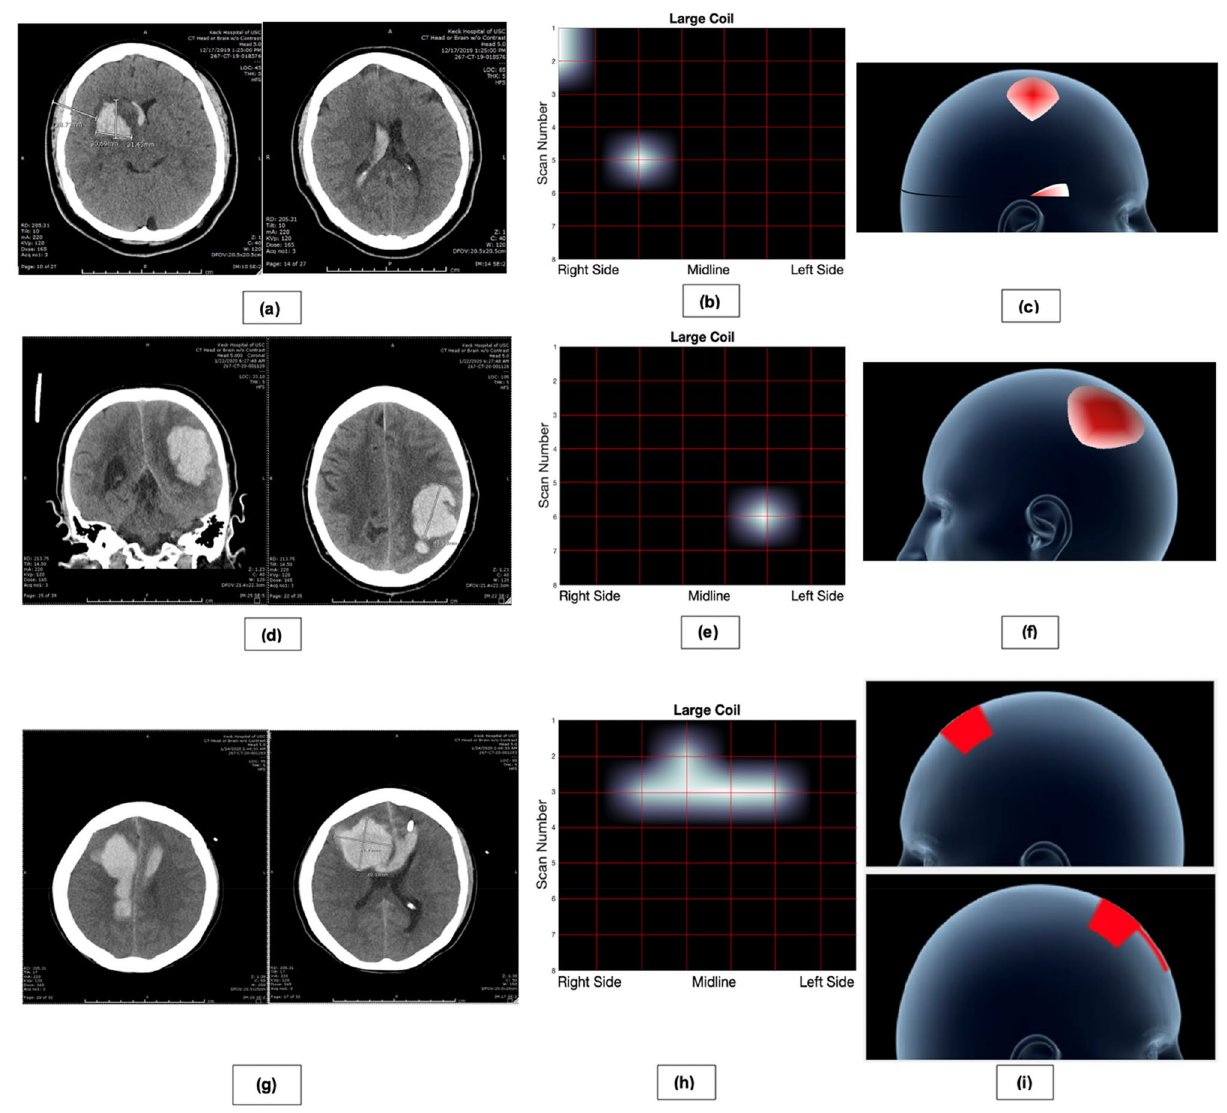
Figure 4. CT imaging, 2D ECD sensor imaging, and 3D ECD sensor imaging for three hemorrhagic stroke patients. The 2D images were produced by continuously scanning across the 8 scanning rows and then averaging each row into 8 equidistant points, with interpolation, to create an 8 × 8 heatmap. As such, lesions are shown on the vertices of the heatmap if detected. To create the 3D images, the 2D heatmaps were projected onto a hemispherical head template. ( a ) CT imaging showing a right basal ganglia ICH and associated IVH in Patient #1. ( b ) Two-dimensional data gathered from ECD sensor. Of note, the Large Coil has the largest magnetic field depth, and thus was able to detect both hemorrhages. ( c ) Three-dimensional projections of each coil. 3D graphics can be created in real-time to rapidly guide clinical judgement and reduce time-to-treatment. ( d ) CT imaging showing a left parietal lobar ICH in Patient #2. ( e ) Two-dimensional data gathered from ECD sensor scanning. ( f ) Three-dimensional projections of the lesion. ( g ) CT imaging showing bilateral ICH, right greater than left in Patient #3. ( h ) Two-dimensional data gathered from ECD sensor scanning. ( i ) Three-dimensional projections of the lesion. The lesion crosses the midline, so two images are provided with left (top) and right (bottom)